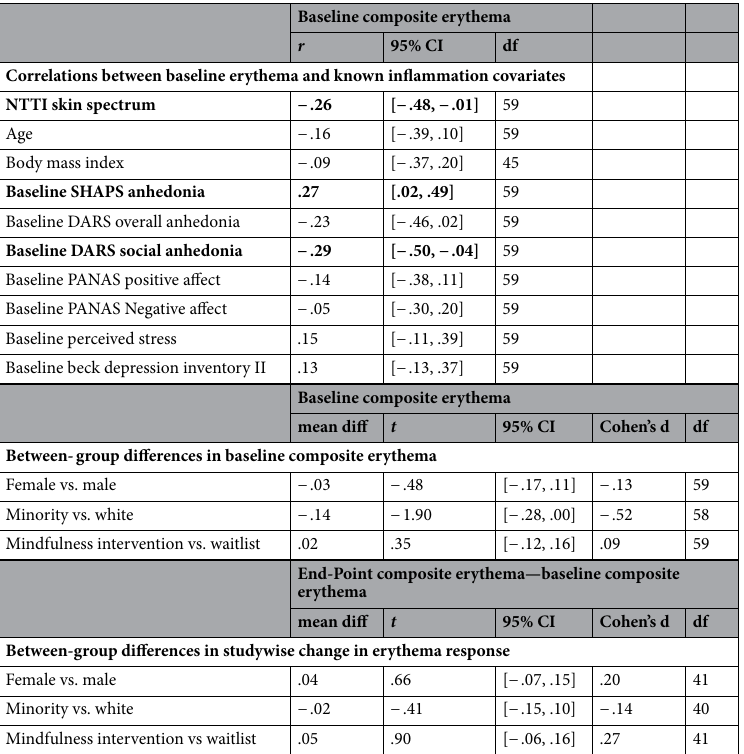
Table 2. Relationships between Composite Erythema and covariates. Significant values are in bold.